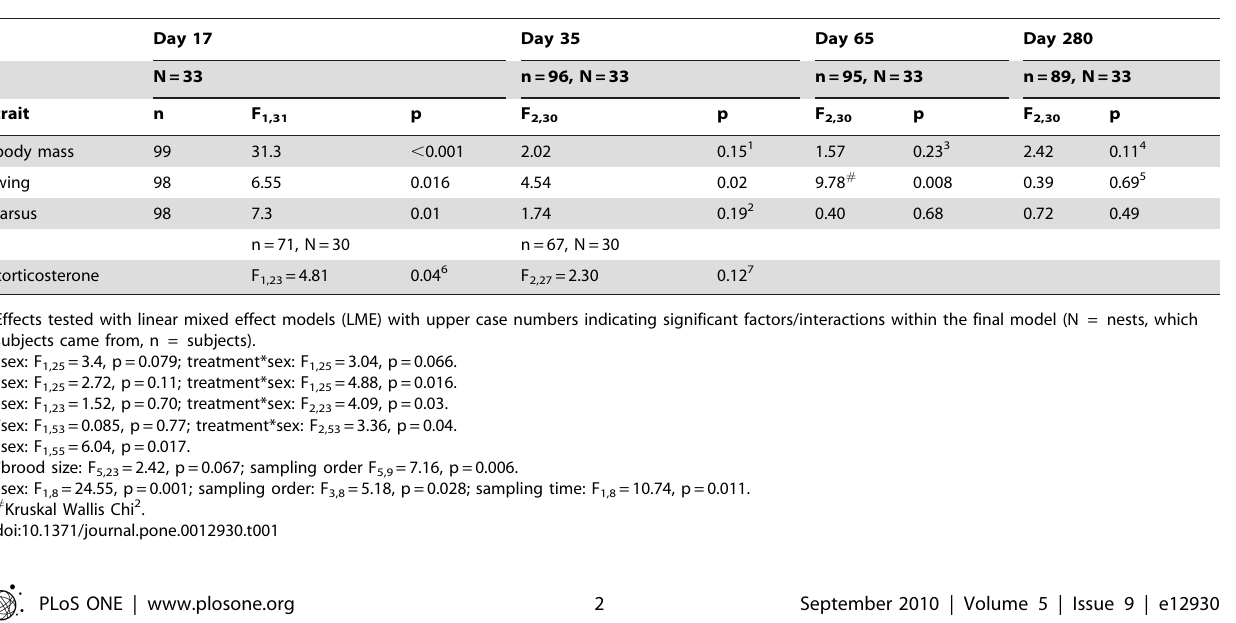
Table 1. Effect of nutrional treatment on biometry and baseline corticosterone levels.